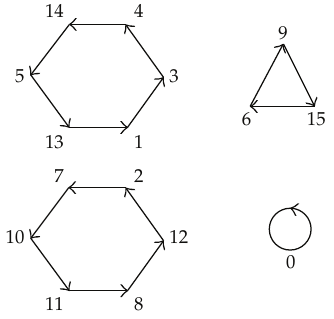
Figure 2: STD of (cid:4) 150 , 150 , 150 , 150 (cid:5)